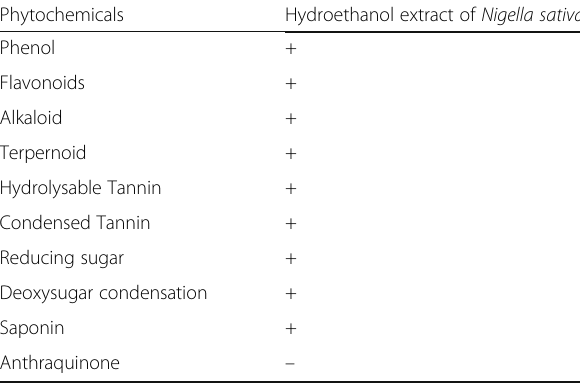
Table 5 The Qualitative phytochemical analyses of ethanol extract Nigella sativa